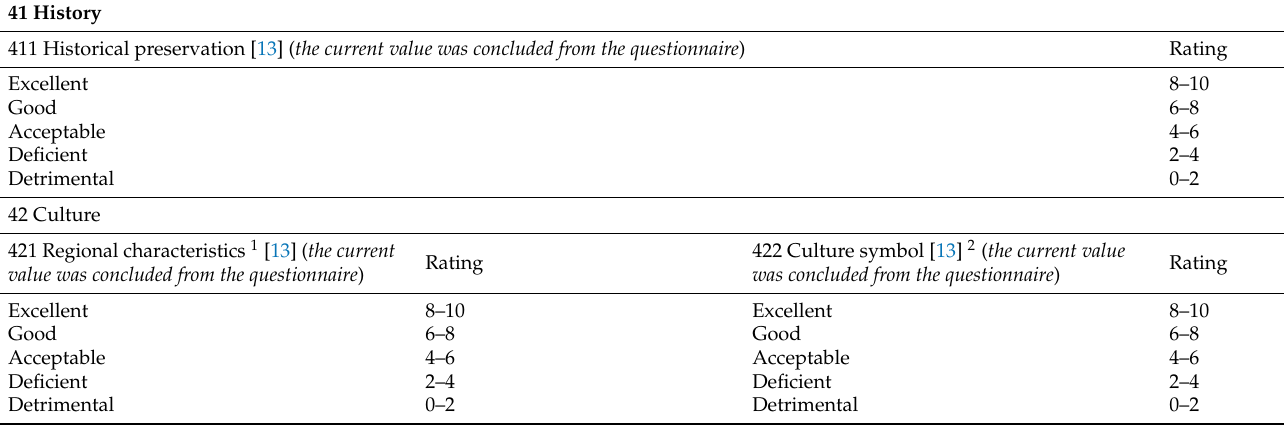
Table 12. Rating for elements of cultural subsystem.